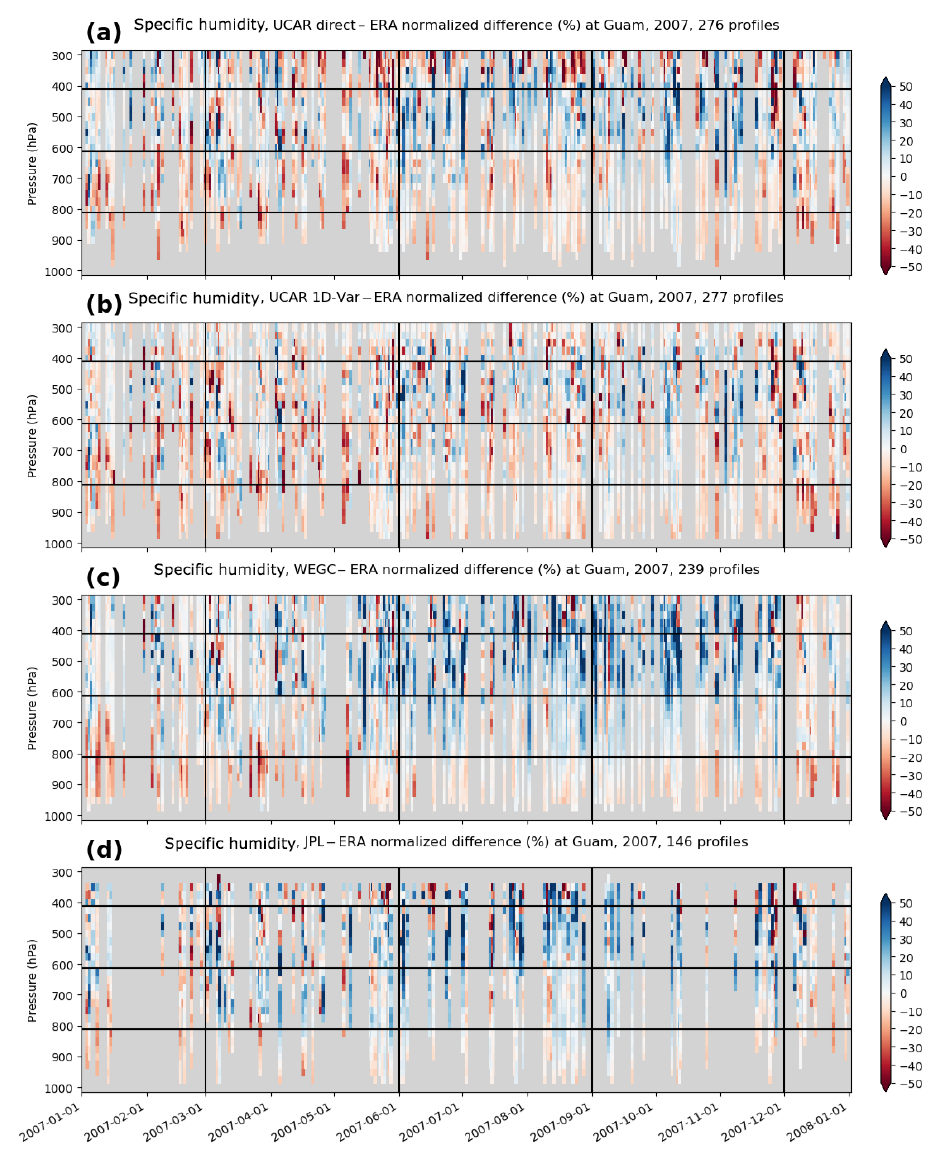
Figure 5. The 2007 time series of the q normalized difference at Guam for the (a) UCAR direct, (b) UCAR 1D-Var, (c) WEGC 1D-Var, and (d) JPL direct retrieval. The color bar on the right indicates specific-humidity normalized differences